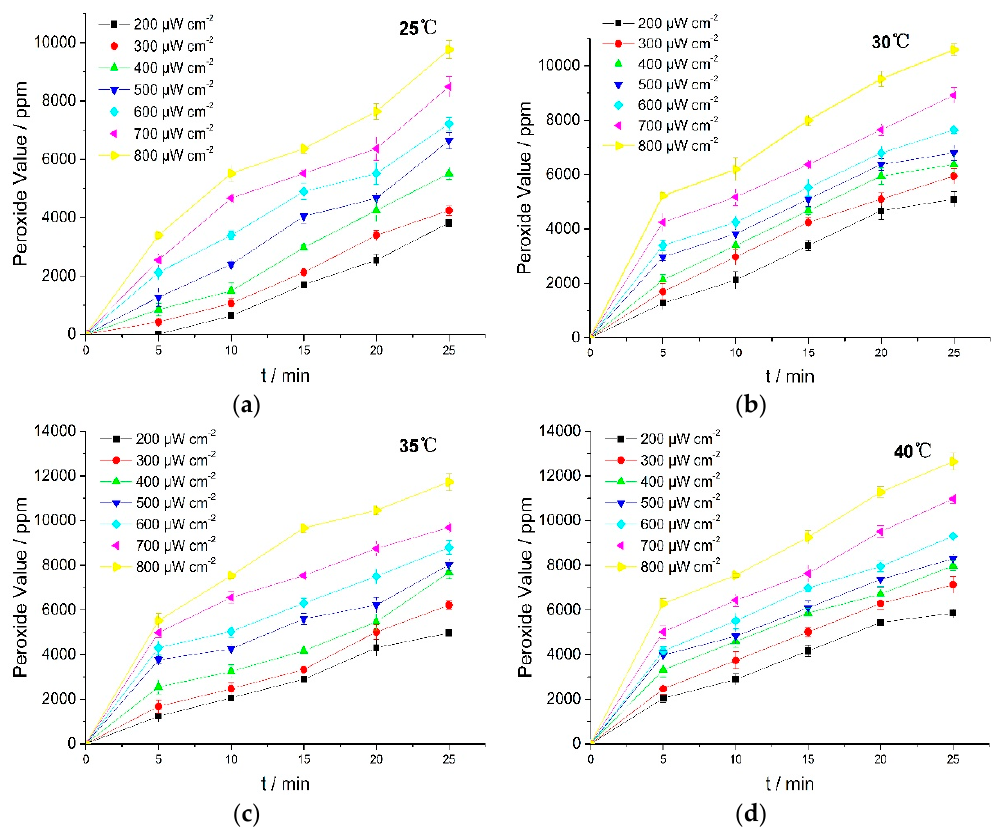
Figure 4. PV of RPE at various temperatures. ( a ) 25 °C; ( b ) 30 °C; ( c ) 35 °C; ( d ) 40 °C.